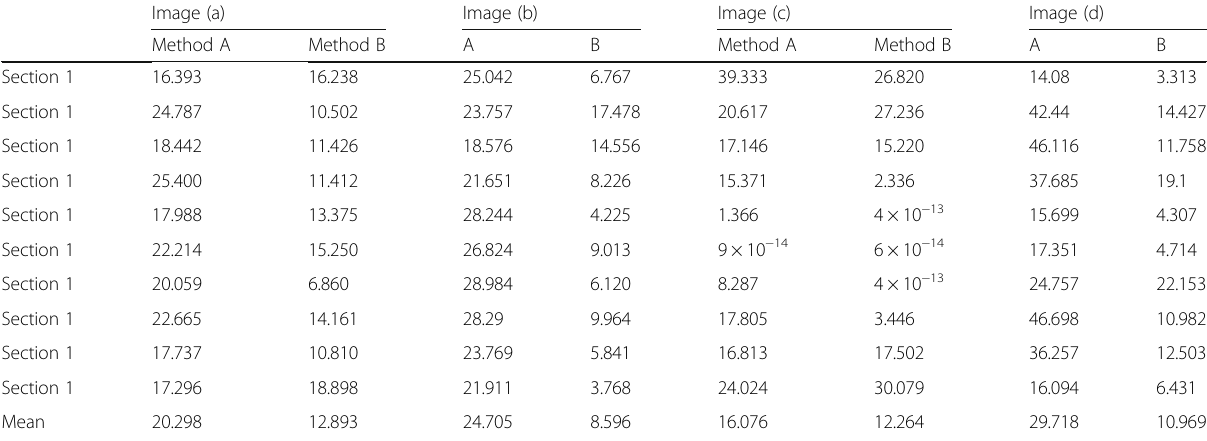
Table 1 Comparison of light stripes gray distribution model fitting residual